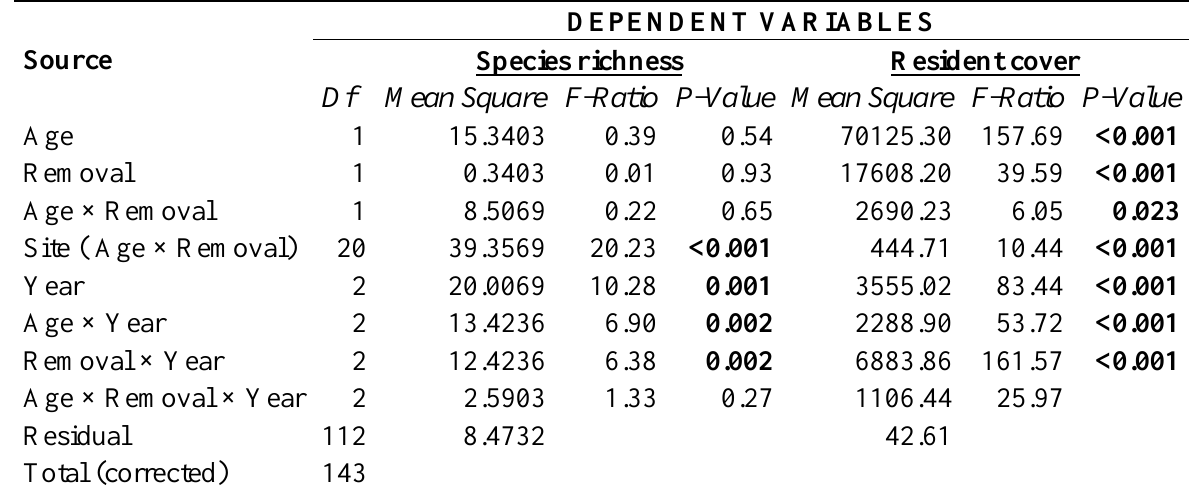
Table 1. Summary of effects of perennial pepperweed colony age, removal, and year, on species richness and percent resident vegetation cover. Bold entries are significant below 0.05.